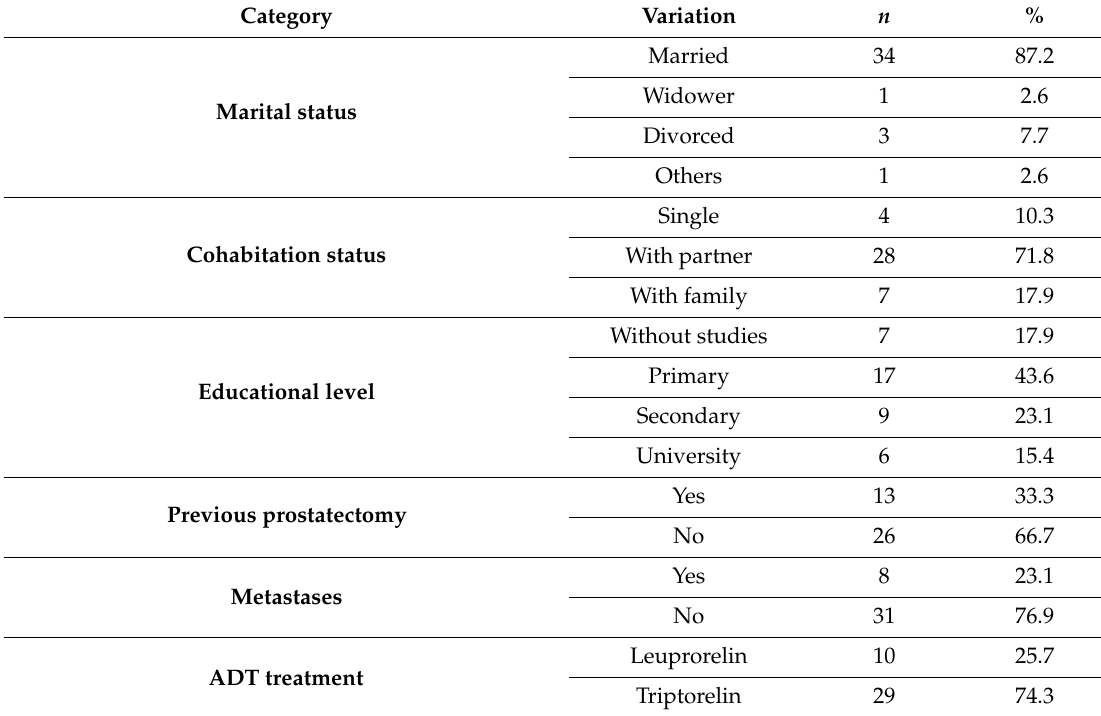
Table 1. Sociodemographic and clinical